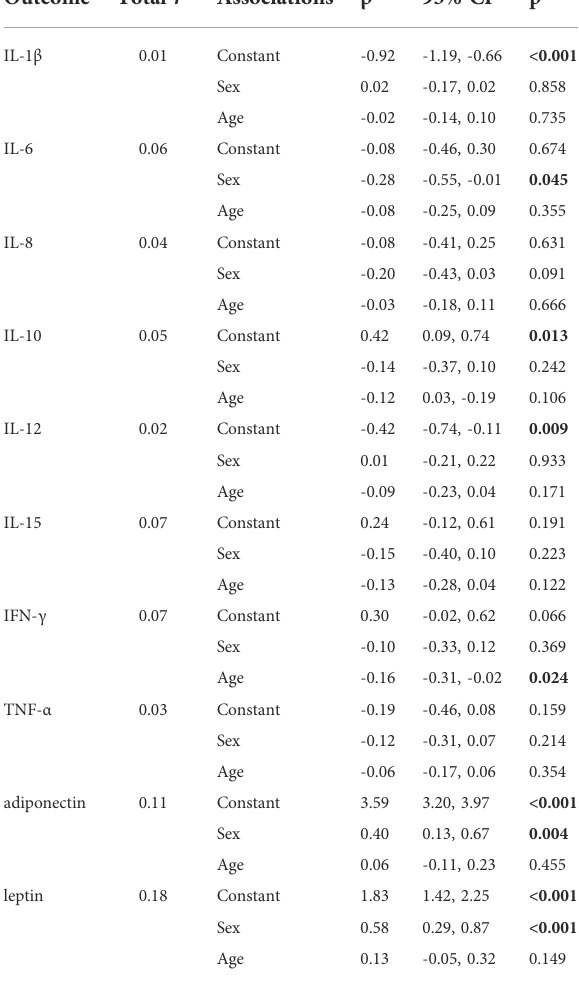
TABLE 3 Impact of age and sex on raw total error of cytokines and adipokines 1